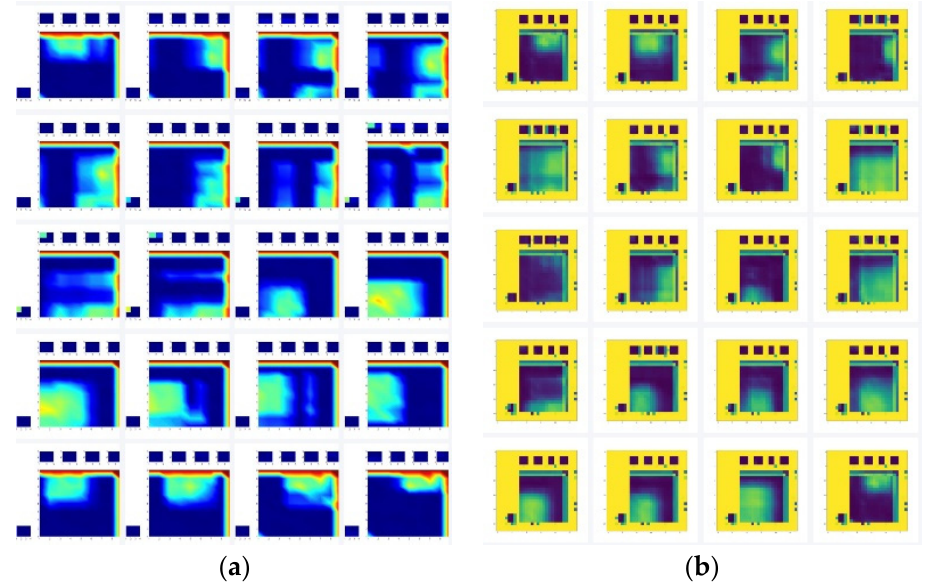
Figure 5. Effect diagram of the variational auto-encoder. ( a ) Origin data; ( b ) Expanded data.